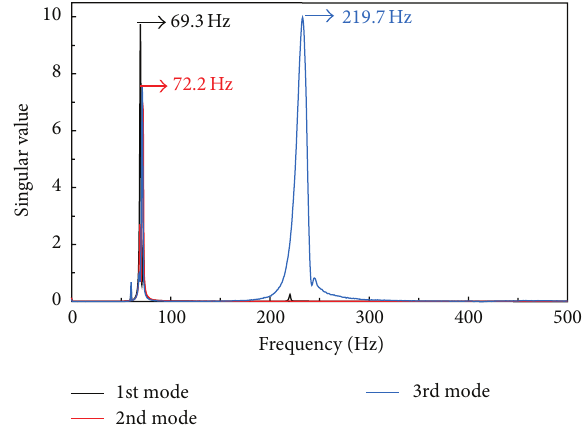
Figure 6: Singular values related to the frequencies for each